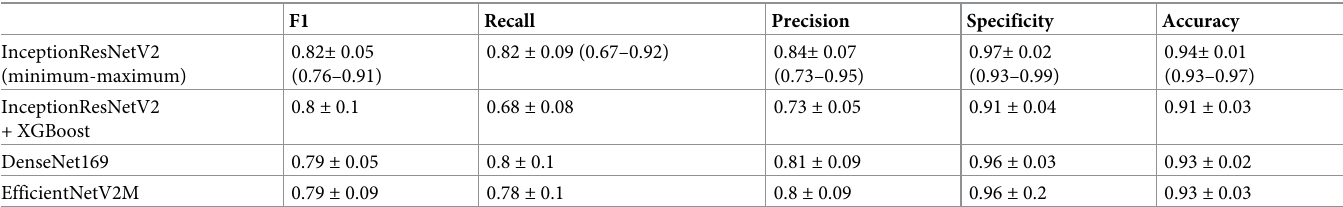
Table 2. Performance of predicting CAC from panoramic images (7-folds CV).